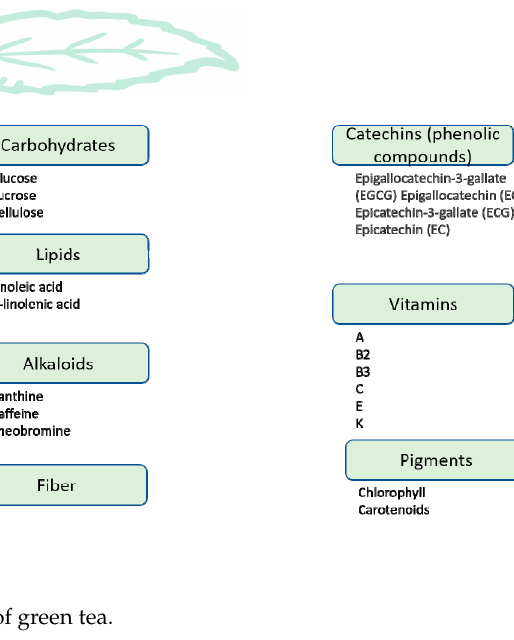
Figure 1. The chemical composition of green tea.